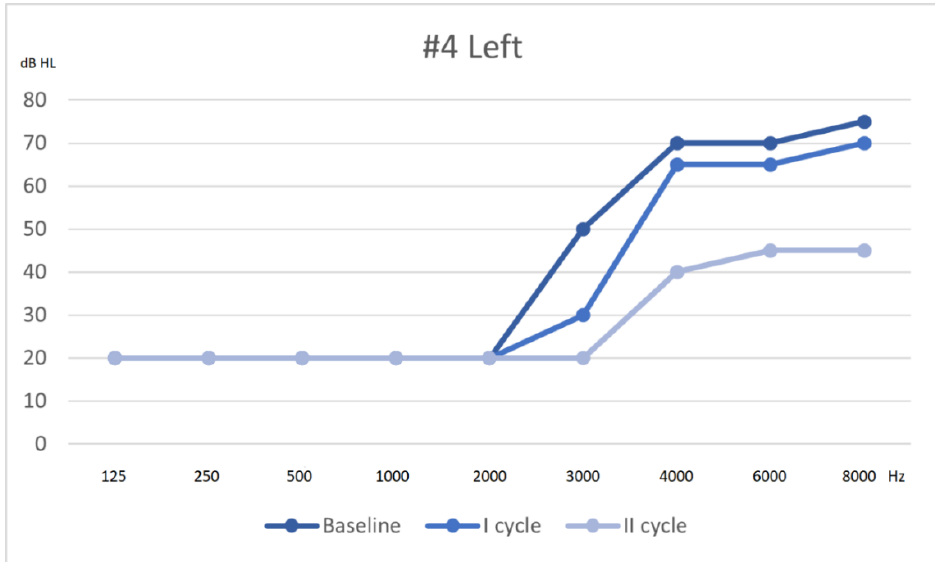
Figure 4. Hearing threshold of the left ear, from baseline to outcome (after 2 cycles of therapy).